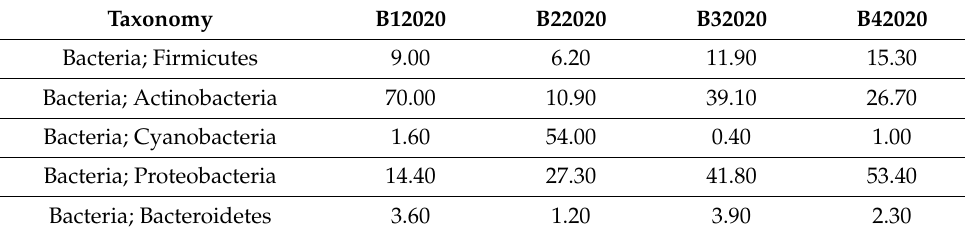
Table 4. Bacterial phylum level recovered in preliminary analyses with tape strips: B12020 strip; B22020 strip left 24 h in a laboratory environment; B32020 strip after contact with tape stripping device; B42020 as B32020 but also in contact with IR